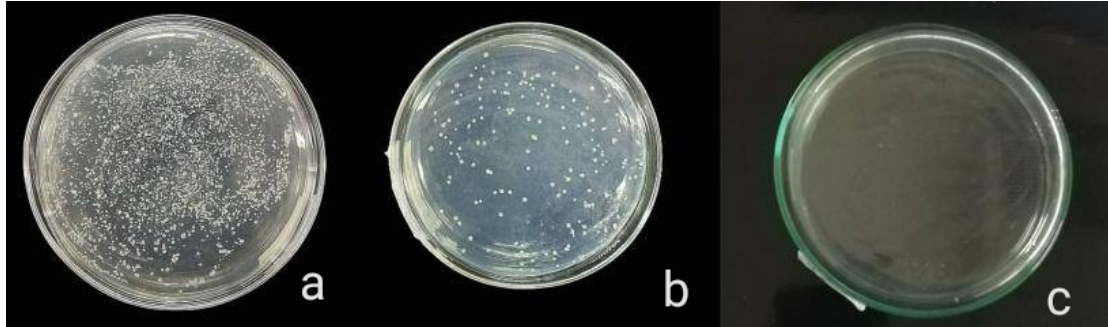
Figure 7. Saliva microcosm bacterial growth of unmodified composite discs ( a ), composite discs with 1% AgNPs ( b ) and composite discs with 1% CIP-AgNPs ( c ).